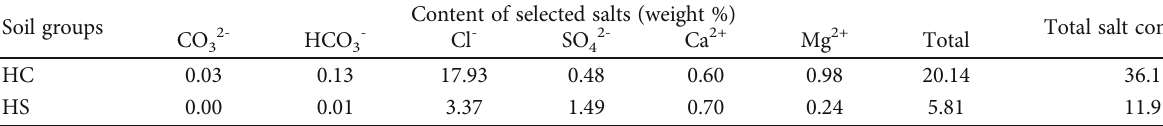
Table 2: Content of di ff erent salts in the saline soils.